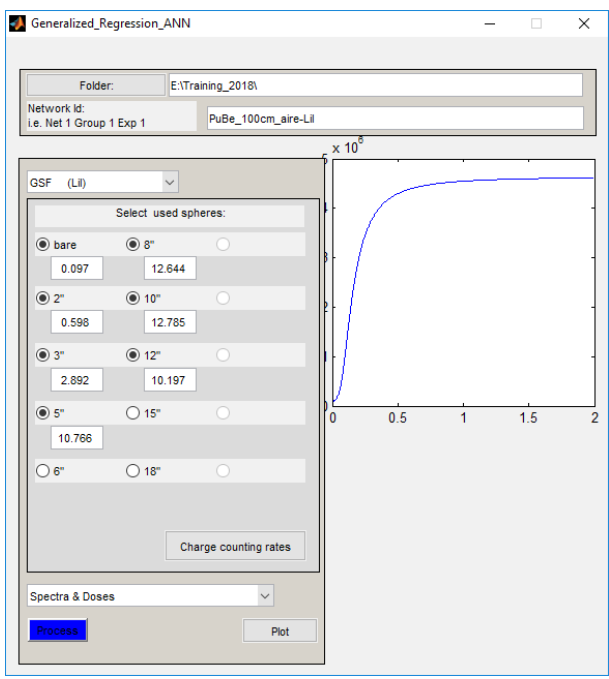
Figure 12. Text boxes for writing the measured experimental rates count